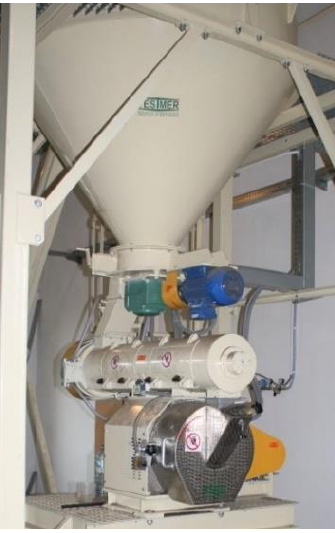
Figure 1. Matrix pelletizer (Testmer, Reguły, Poland).